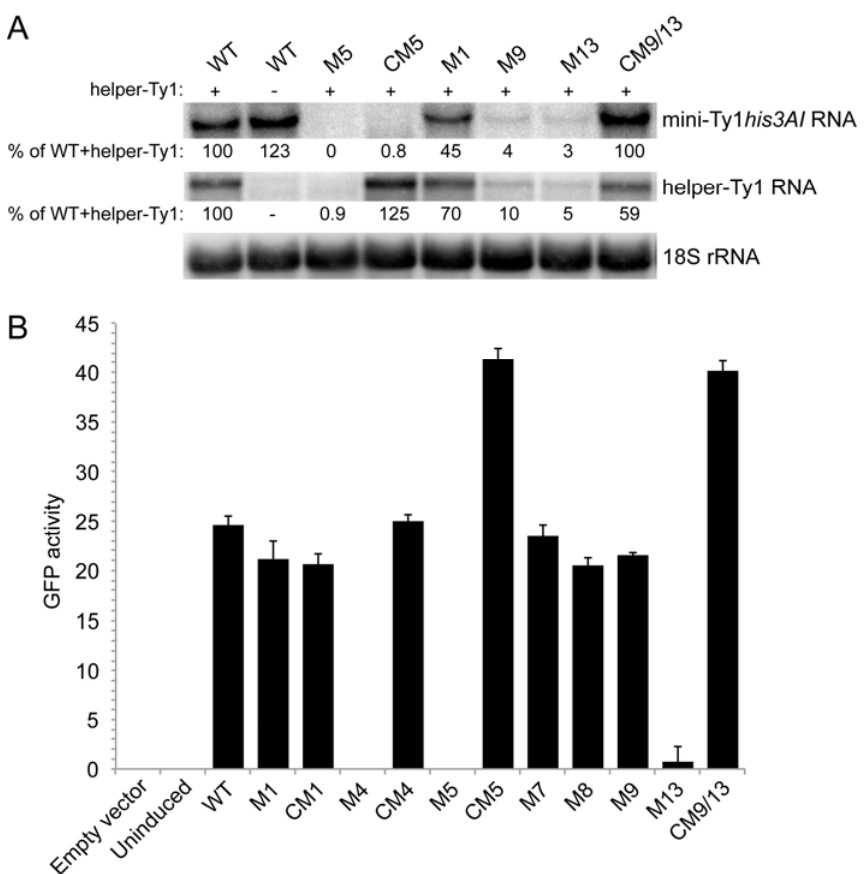
Figure 8. Levels of mini-Ty1 his3AI RNA bearing different mutations and helper-Ty1 RNA. ( A ) Northern blot analysis of strains carrying the p GAL1 :mini-Ty1 his3AI plasmid harboring wild-type Ty1 sequences (WT) or mutant Ty1 sequences and the p GAL1 :helper-Ty1 induced for 24 hours in galactose-containing medium. The presence or absence of the p GAL1 :helper-Ty1 plasmid is indicated by + and – symbols, respectively, above the blot. Labels for mutations correspond to those in Figures 6 and 7; ( B ) Measurement of the median GFP activity in 10,000 cells of two different transformants of each p GAL1:GAG NT :GFP plasmid containing wild type Ty1 TIPIRT domain sequences or derivatives with mutations named as 2.5 h. Error bars are the standard deviation of the median GFP activity in each of two